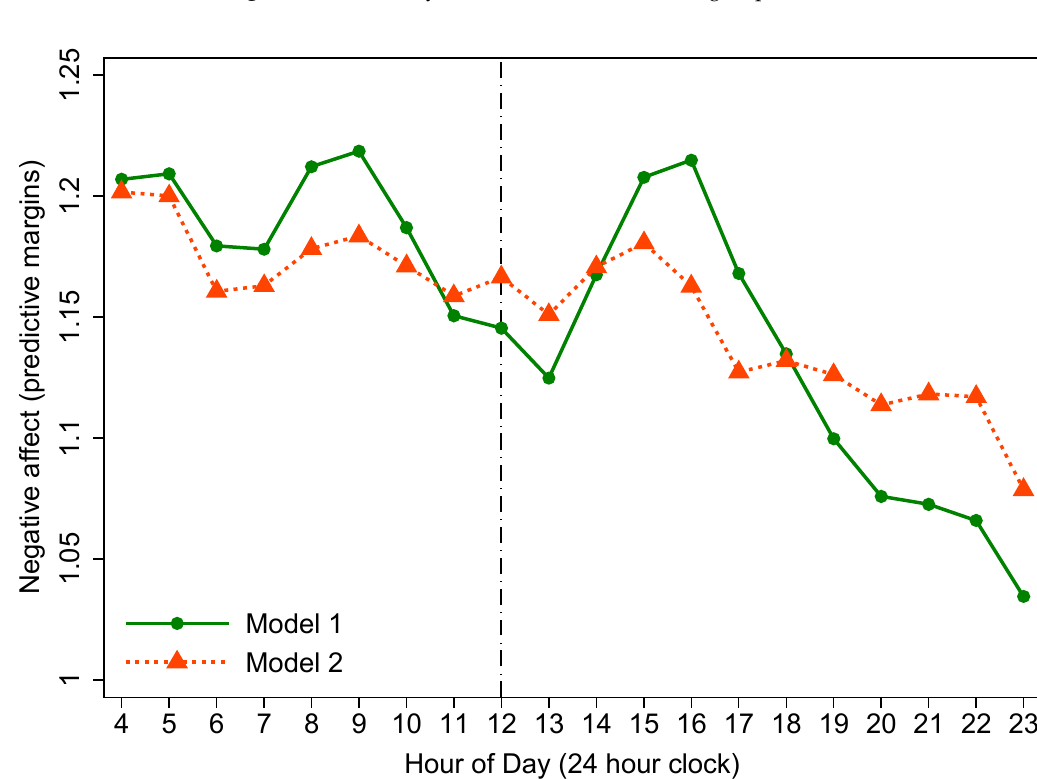
Figure 4. Diurnal rhythm of negative affect (reference group: 4:00).